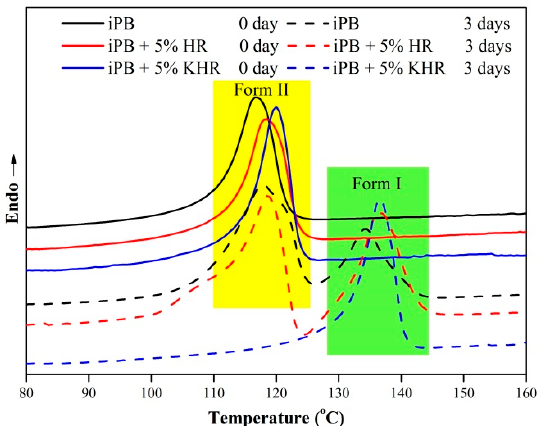
Figure 4. The melting curves of the samples at 25 °C for different annealing time.